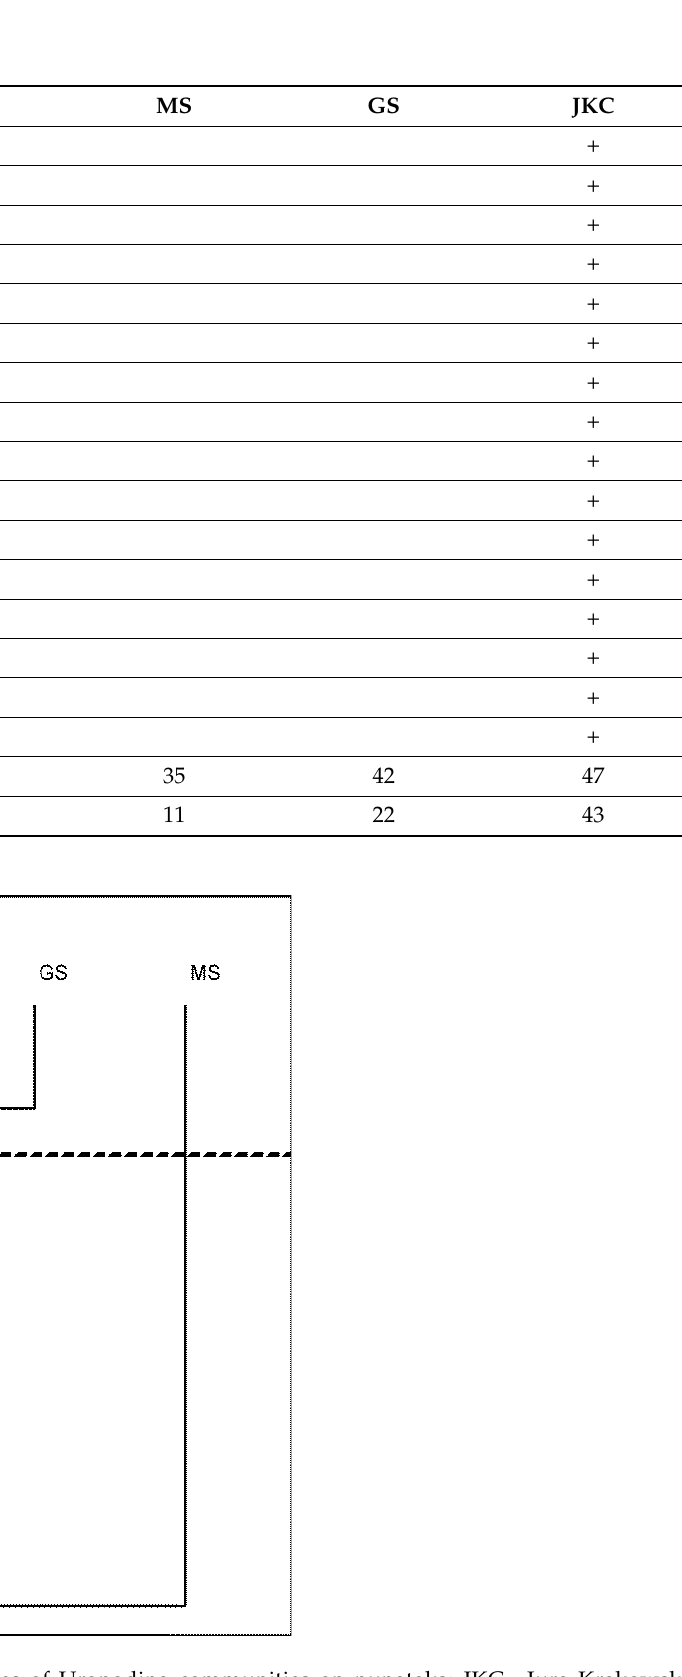
Figure 8. Species similarities of Uropodina communities on nunataks; JKC—Jura Krakowsko-Cz ę stochowska, GS— Ś wi ę tokrzyskie Mountains, MS— Ś l ęż a Massif.